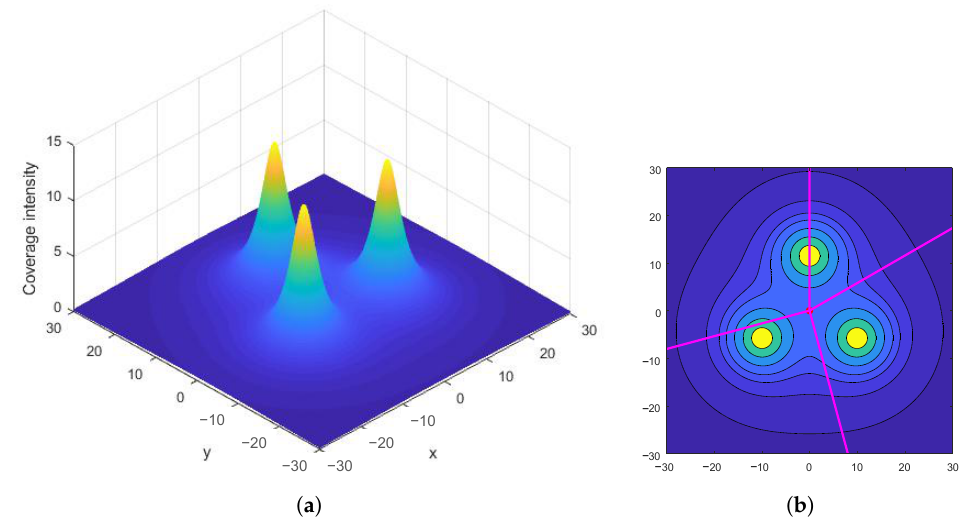
Figure 2. Coverage intensity of a 3-node team forming an equilateral triangle, with the nodes being located on the vertices. ( a ) Three-dimensional illustration, where the z -axis is the coverage intensity and the three peaks locate the three nodes; ( b ) contour plot with four arbitrary example rays.